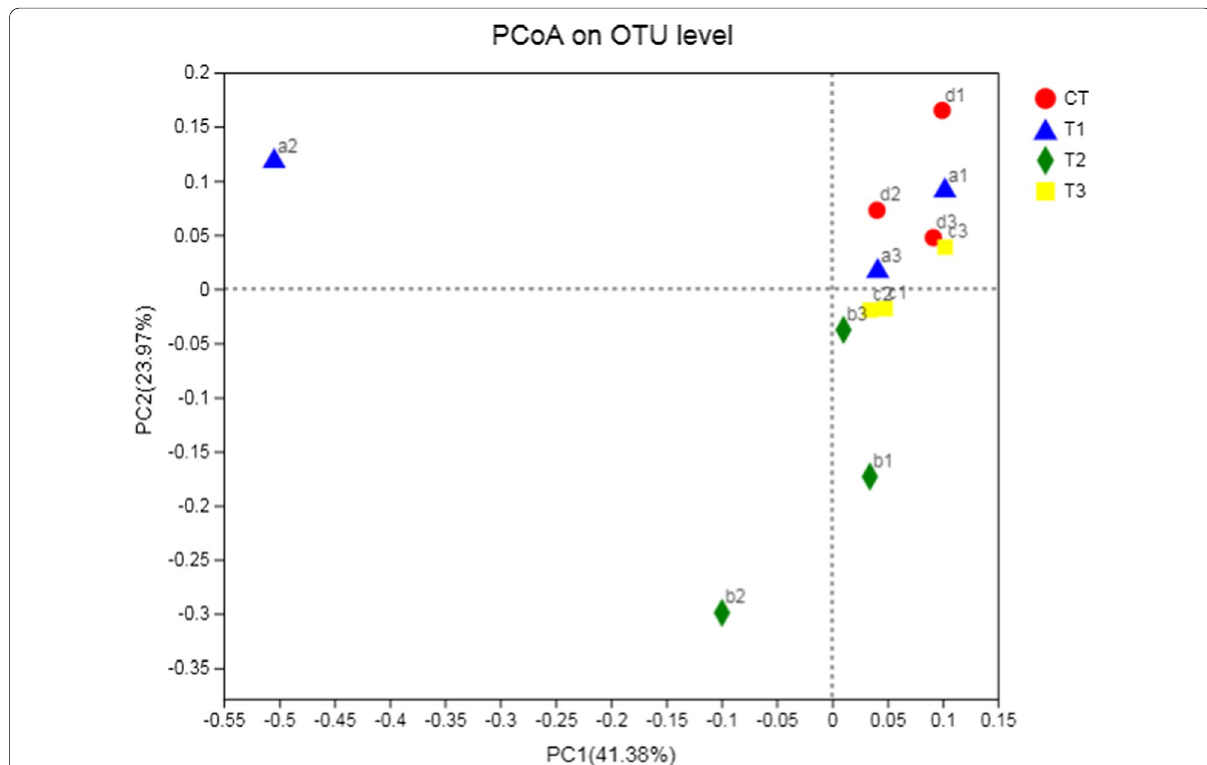
Fig. 2 Pocan analysis of archaeal population in the rumen of water buffaloes. CT (a1, a2, a3), T1 (b1, b2, b3), T2 (c1, c2, c3), T3 (d1, d2,